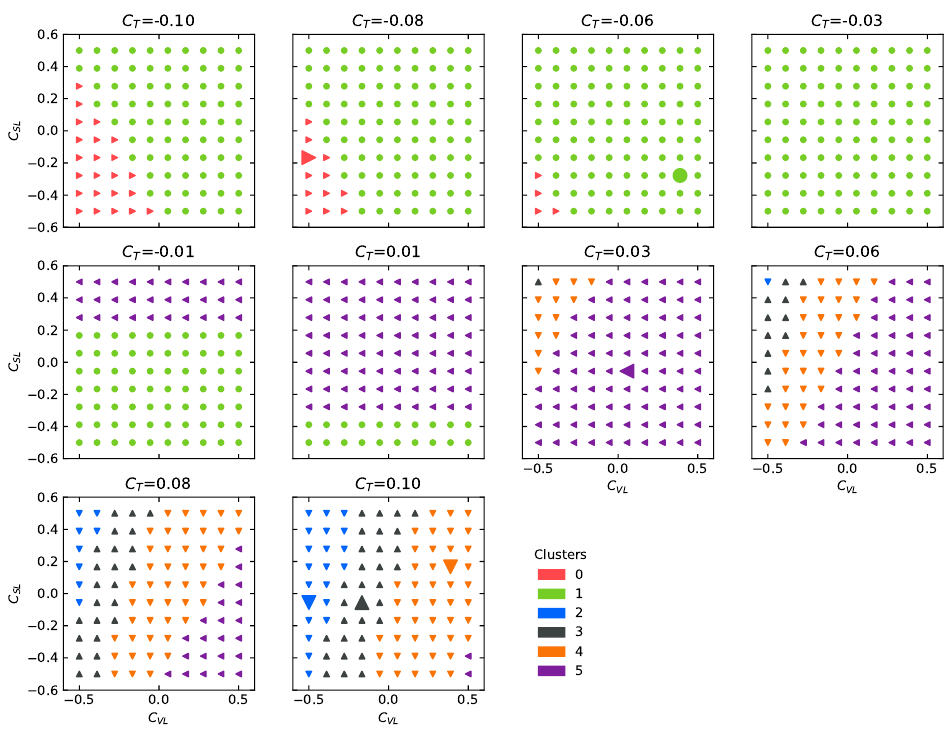
Figure 1 . Two-dimensional cuts of the clustered parameter space resulting from dBR( B ! D 0 (cid:3) (cid:28)(cid:23) ) = d(cos( (cid:18) (cid:28) )) distributions are shown. The parameter space is spanned by the three Wil- son coe(cid:14)cients C V L ; C SL and C T , varied within their respective ranges. Six di(cid:11)erent clusters are found in our approach, which are indicated with di(cid:11)erent markers and colours. BPs are given in